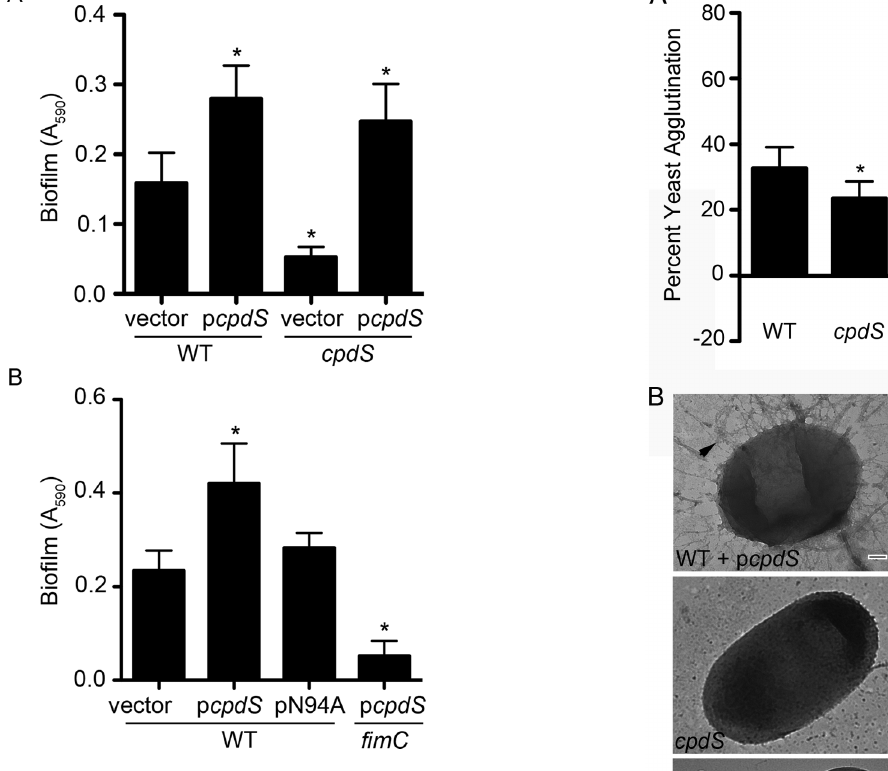
Figure 4. CpdS mediates S.marcescens biofilm formation. A–B . Quantification of crystal violet stained biofilms from the sides of glass test tubes grown under high-sheer conditions. Vector = pMQ131; p cpdS = pMQ171; pN94A = pMQ176. The asterisk indicates statistical difference from wild-type levels (n=9, p , 0.05, ANOVA with Tukey’s post-test).